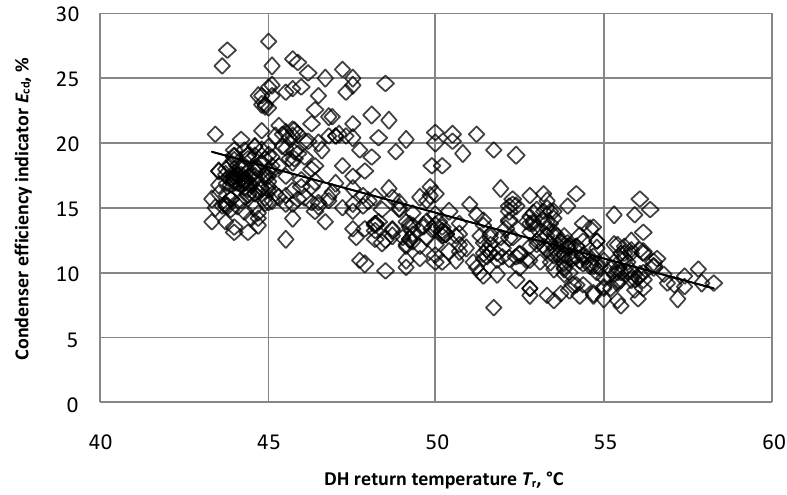
Fig. 7. Changes in condenser efficiency indicator depending on DH network return